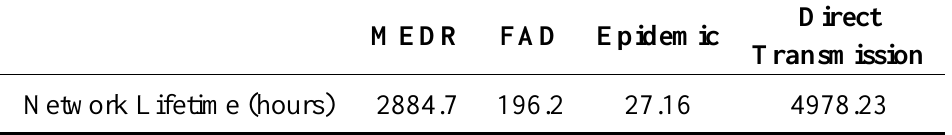
Table 3. Network life without the energy consumed by hello